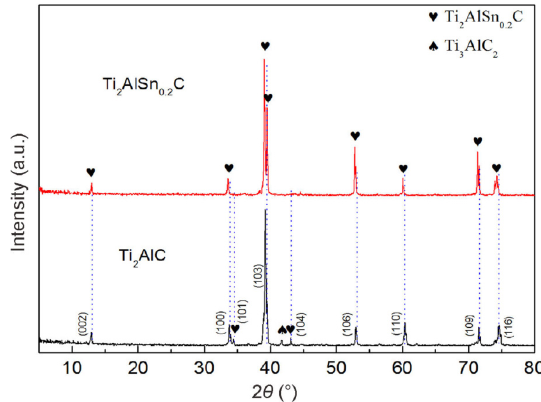
Fig. 2 XRD patterns for Ti 2 AlC and Ti 2 AlSn 0.2 C